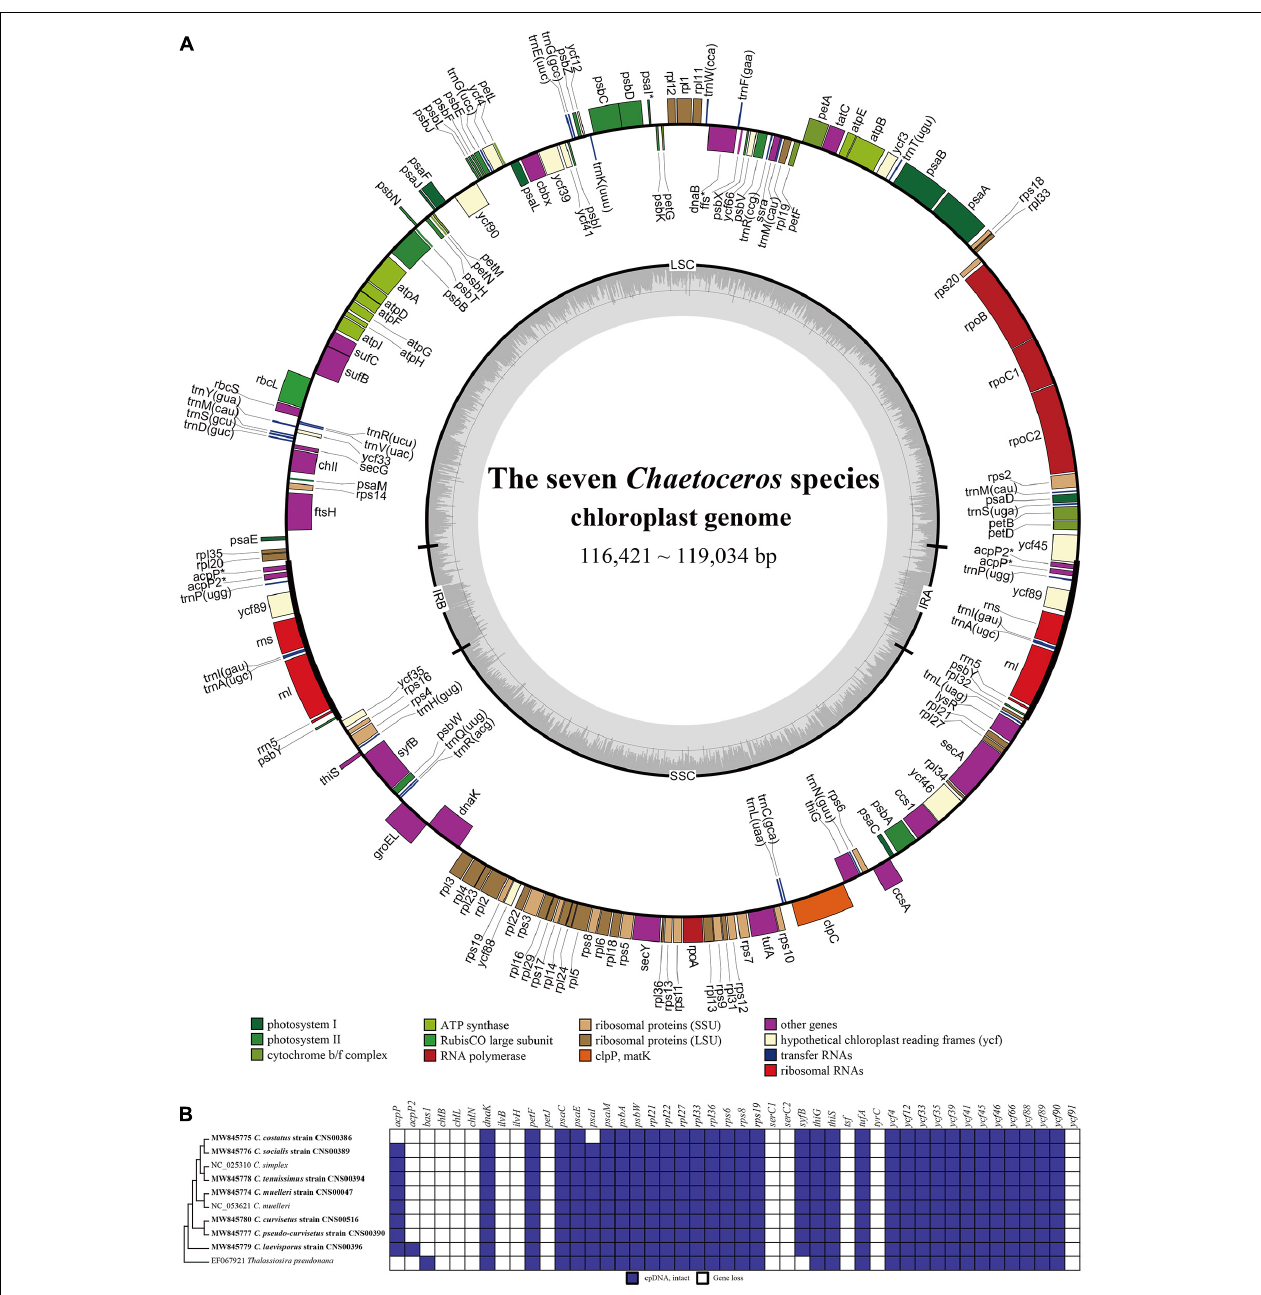
FIGURE 2 | Gene structural and evolutionary patterns of genes of the Chaetoceros cpDNAs. (A) Map of cpDNAs of the seven Chaetoceros . Dashed area in the inner circle indicates the GC content of the cpDNA. Genes belonging to different functional groups are color-coded as indicated by icons on the lower. The asterisk represents differences between the seven Chaetoceros . (B) Evolutionary patterns of loss, and gain of genes in Chaetoceros cpDNAs. The matrix shows 46 genes variably present among the sequenced genomes. Taxa in boldface identify genomes sequenced for this study. Phylogenetic relationships based on concatenated amino acid sequences of protein-coding genes using Maximum likelihood (ML) methods. T. pseudonana was used as out-group